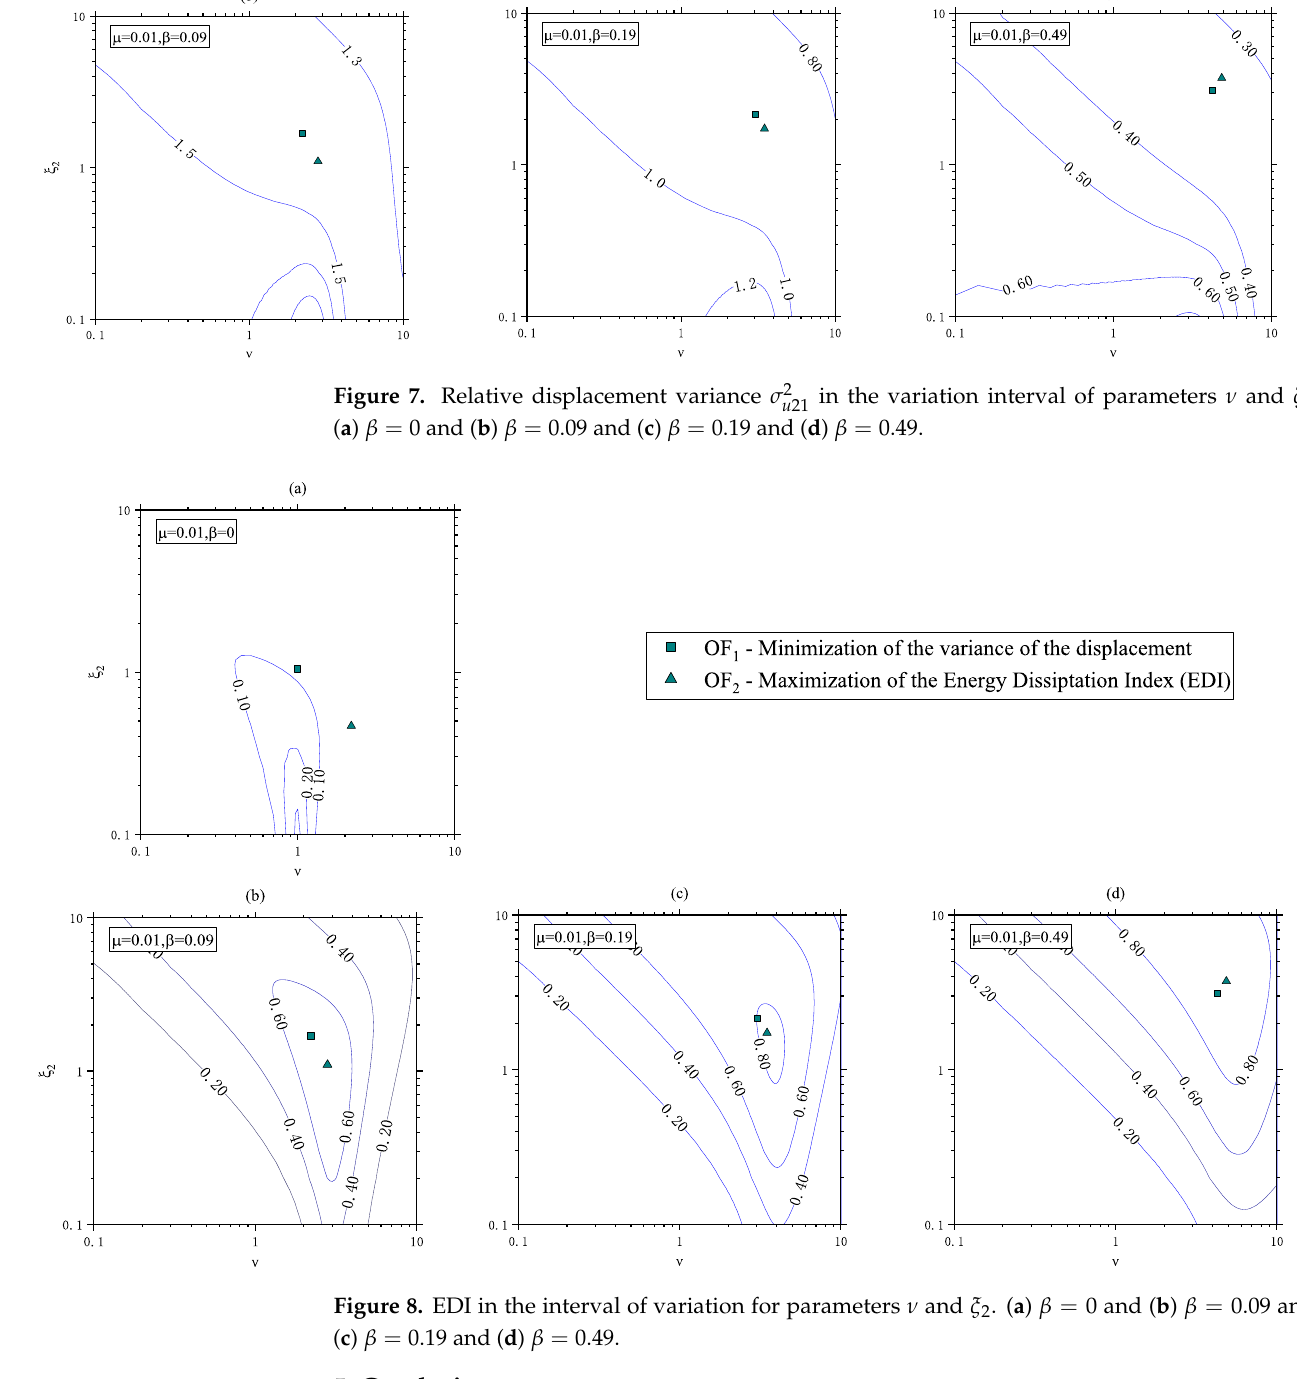
( c ) β = 0.19 and ( d ) β = Figure 8. EDI in the interval of variation for parameters 𝜈 and 𝜉 (cid:2870) . (a) 𝛽 = 0 and (b) 𝛽 = 0.09 and (c) 𝛽 = 0.19 and (d) 𝛽 = 0.49.